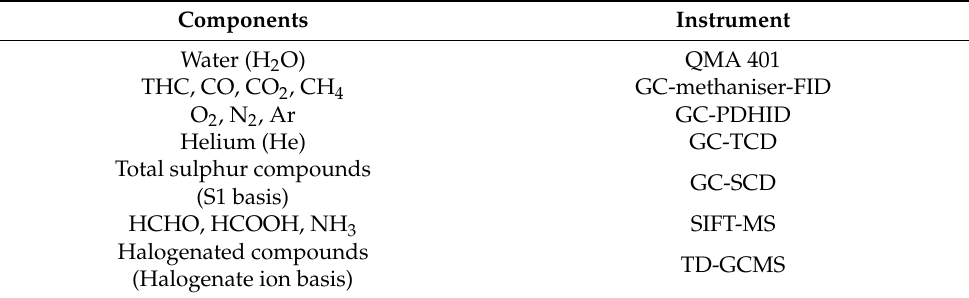
Table 1. Analytical Methods for ISO 14687 contaminants.